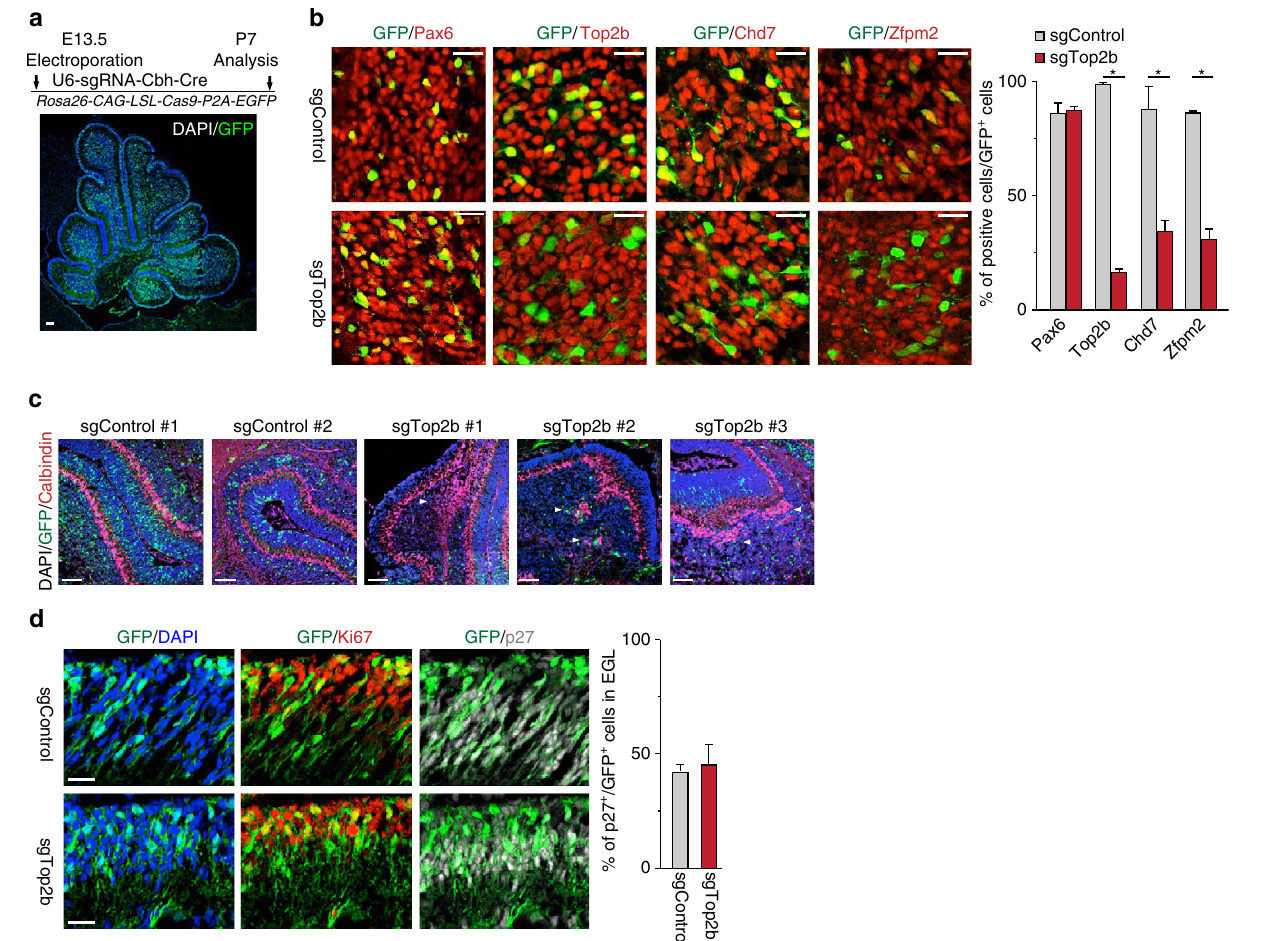
Figure 7 | Genetic ablation of Top2b leads to phenotypic changes analogous to Chd7 -deficient cerebella. ( a ) Immunostaining of GFP (green) on P7 cerebellum from Rosa26-CAG-LSL-Cas9-P2A-EGFP mouse that was electroporated at E13.5 with a plasmid carrying sgRNA and Cre. Section is counterstained with DAPI (blue). Scale bar, 100 m m. The experimental scheme is shown in the top panel. ( b ) Immunostaining of GFP and Pax6, Top2b, Chd7 and Zfpm2 on P7 cerebella from Rosa26-CAG-LSL-Cas9-P2A-EGFP mouse that was electroporated at E13.5 with a plasmid construct expressing Cre and sgRNA against Top2b (sgTop2b) and a control sequence (sgControl). Quantification of positive cells among GFP þ cells is shown in the right panel. Two and three pups were analysed for sgControl and sgTop2b, respectively. P ¼ 8.567E-06 (for Top2b), P ¼ 0.0037 (for Chd7), P ¼ 0.00046 (for Zfpm2). Scale bars, 20 m m. ( c ) Immunostaining of GFP (green) and Calbindin (red) of P7 sgControl- and sgTop2b-electroporated cerebella. Arrowheads highlight mislocalized Purkinje cells. Scale bars, 100 m m. ( d ) Immunostaining of GFP (green), Ki67 (red) and p27 (white) of the EGL from P7 sgControl- and sgTop2b-electroporated animals. Quantification of p27 þ cells among GFP þ cells was shown in the right panel. Scale bars, 20 m